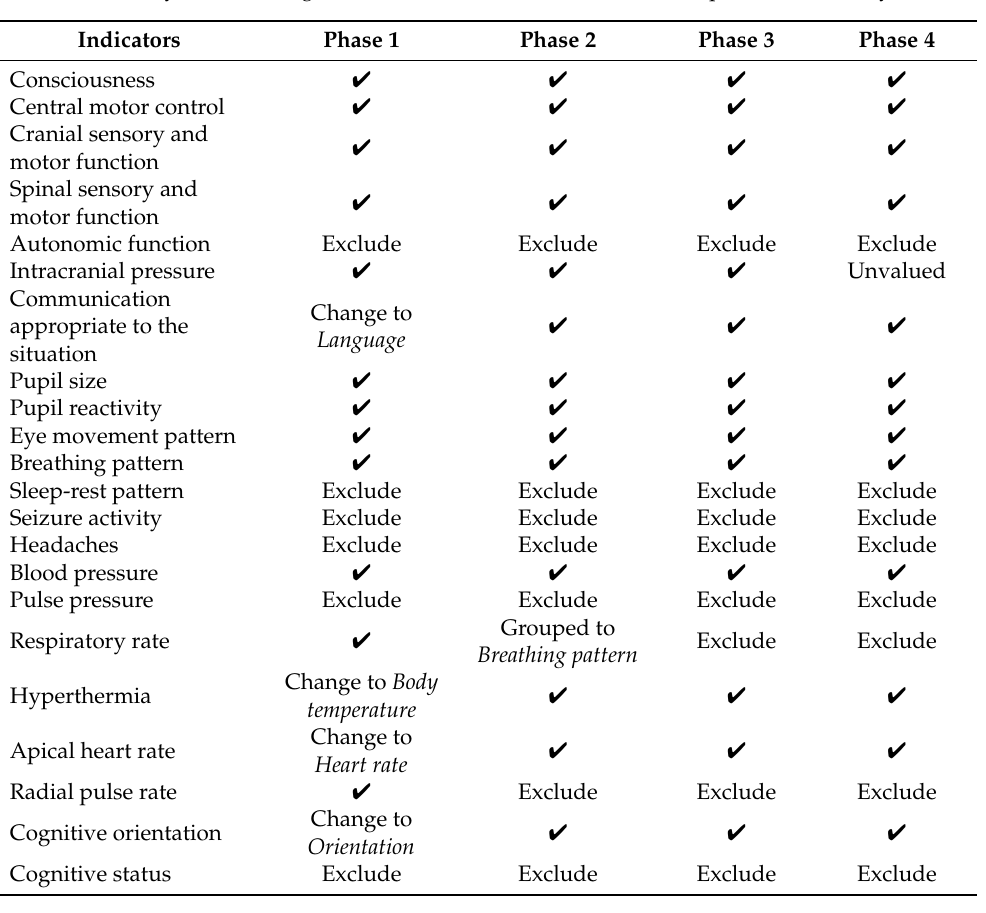
Table 2. Summary of “Neurological Status” indicators validated at each phase of the